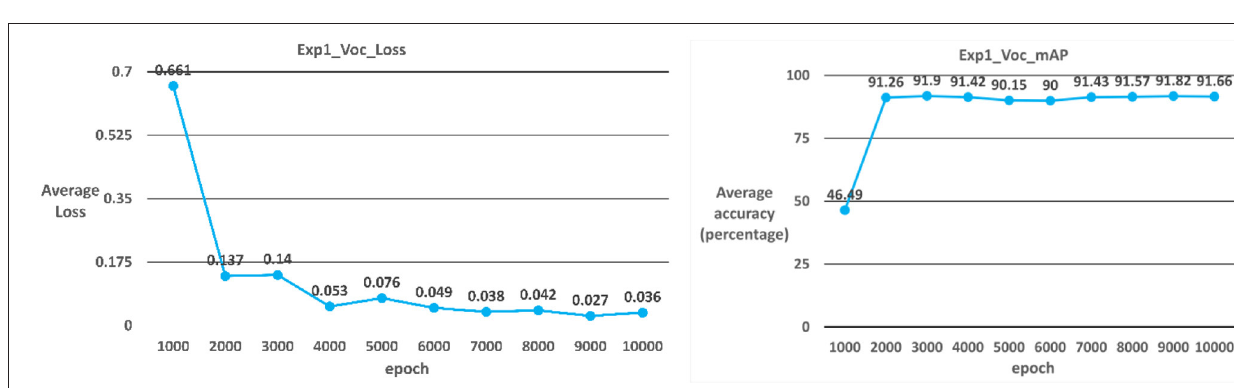
FIGURE 6 | YOLOv3_tiny average error rate and average accuracy rate.